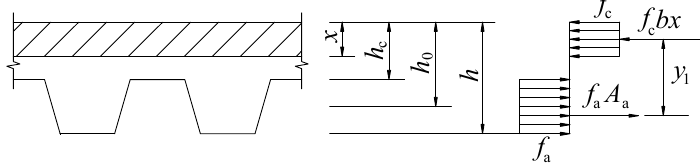
Figure 21. Calculating diagram of flexural capacity of composite slabs.